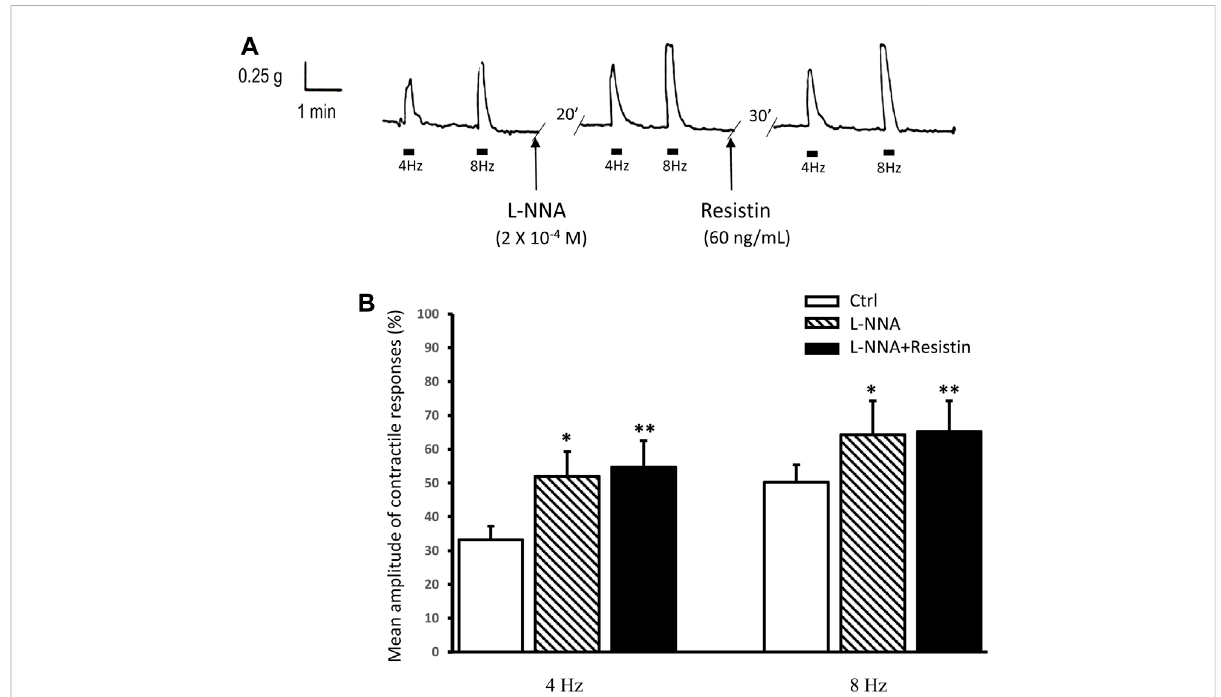
FIGURE 2 Lack of effects of resistin on the neurally-evoked contractile responses in the presence of L-NNA. (A) : representative trace showing the EFS- evoked contractile responses at 4 and 8 Hz stimulation frequency (left hand panel). Addition of 2 × 10 − 4 M L-NNA to the bath medium enhances the amplitude of the neurally-evoked contractile responses (middle panel). In the presence of L-NNA, resistin (60 ng/ml) no longer depresses the amplitude of the EFS-evoked contractile responses (right hand panel). (B) : bar chart showing the lack of effects of resistin on the mean amplitude of theneurally-evoked contractile responses inthe presence of L-NNA. Amplitude ofcontractile responses is expressed as percentageof the muscular contraction induced by 2 × 10 − 6 M methacholine, taken as 100%. All values are means ± SEM of 8 strips (from 4 animals). * p < 0.05